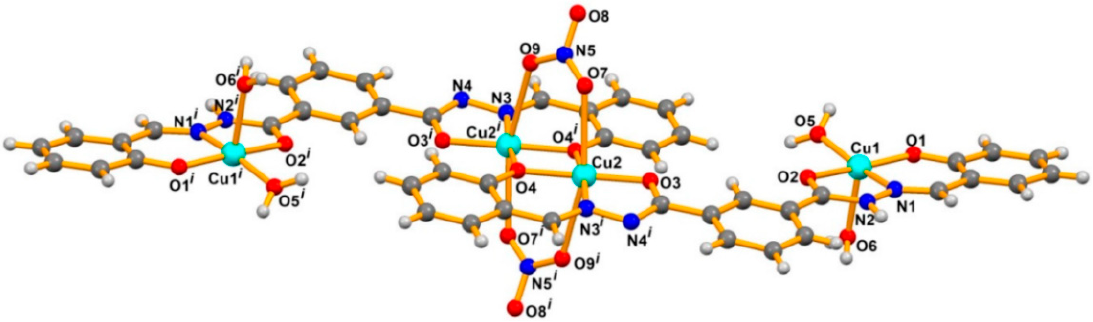
Figure 6. Complex 8 Adapted from Ref. [67], Copyright (2018), Molecules (MDPI).